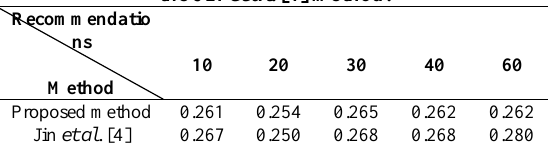
Table 3. Comparison of the proposed method with the Jin et al . [4] method.